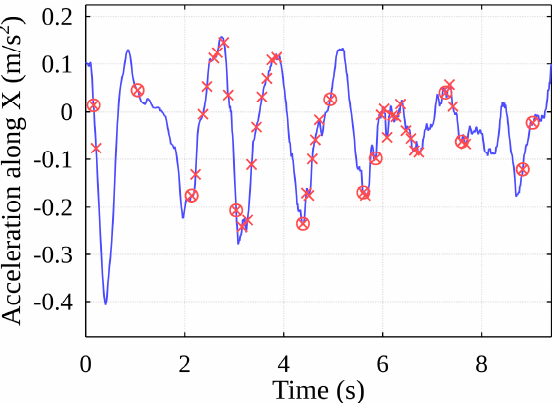
Figure 31. Detected events mapped on data of acceleration along the X-axis.